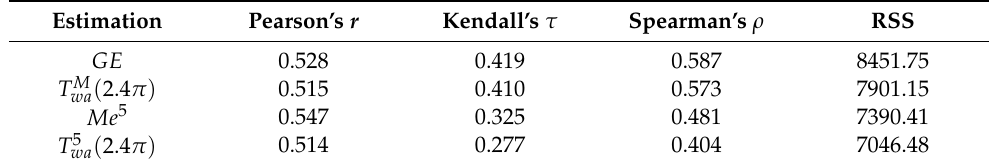
Table 6. Evaluation of models with 64 missing